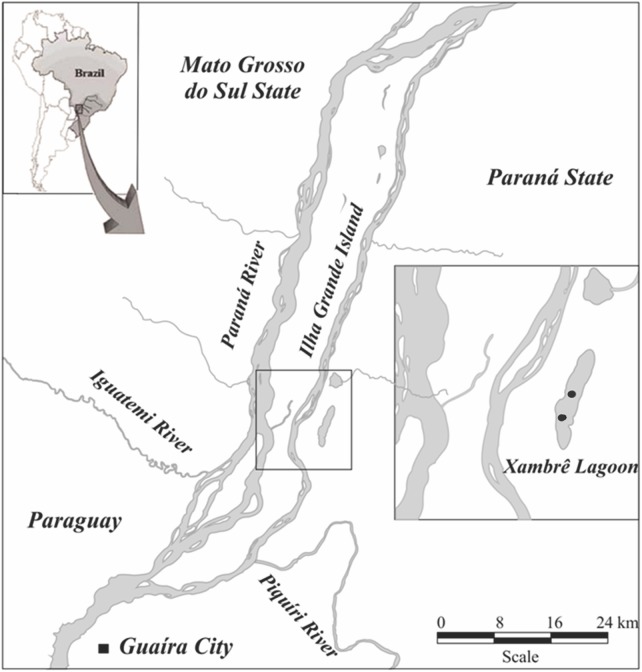
Study area: Upper Paraná River floodplain–Xambrê Lake, Parque Nacional de Ilha Grande, Paraná State, Brazil.